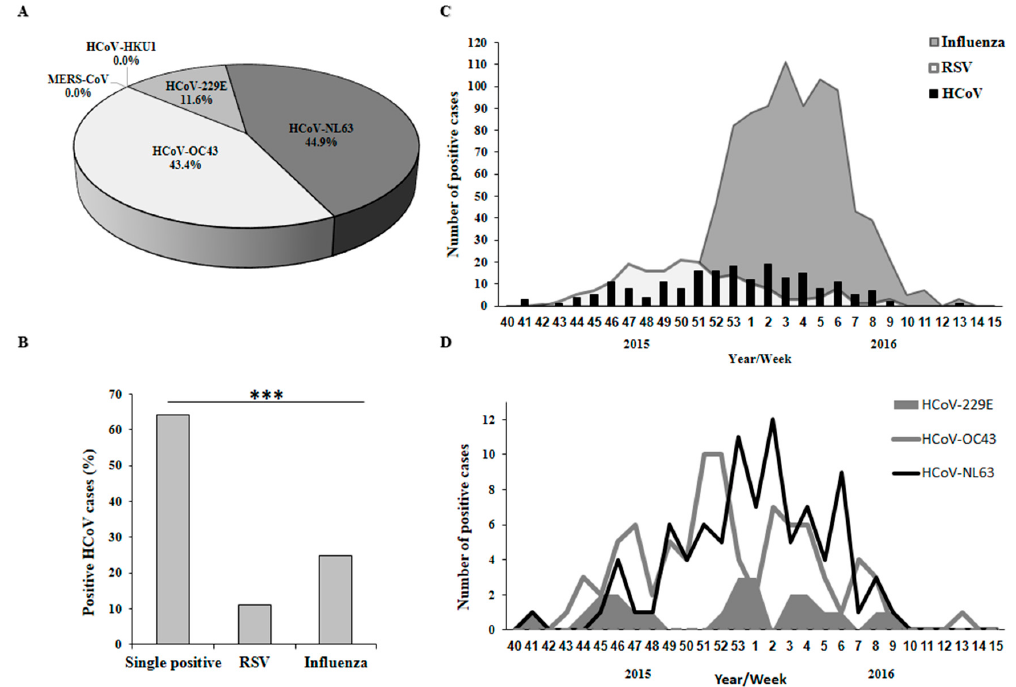
Figure 1. Respiratory viruses in the population during winter season 2015–2016. ( A ) Percentages of Human coronaviruses (HCoV) types. Pie chart presenting percentages of HCoV types among the 1910 influenza-like illness (ILI) samples collected in the 2015–2016 winter season; ( B ) Proportions of single and double-positive HCoV-positive samples. All samples were separated into three groups—HCoV, influenza, and respiratory syncytial virus (RSV). Each group was then separated to HCoV positive/negative. The bars represent the percentage of sample containing only HCoV (single positive) or co-infection with RSV or influenza. The chi-square statistic is 35.9447 and the p -value is < 0.00001; ( C , D ) Distribution of respiratory virus infection in the 2015–2016 winter season, starting from the 40th week of 2015 until the 15th week of 2016. ( C ) Distribution of HCoV, RSV and influenza viruses; ( D ) Distribution of HCoV types.